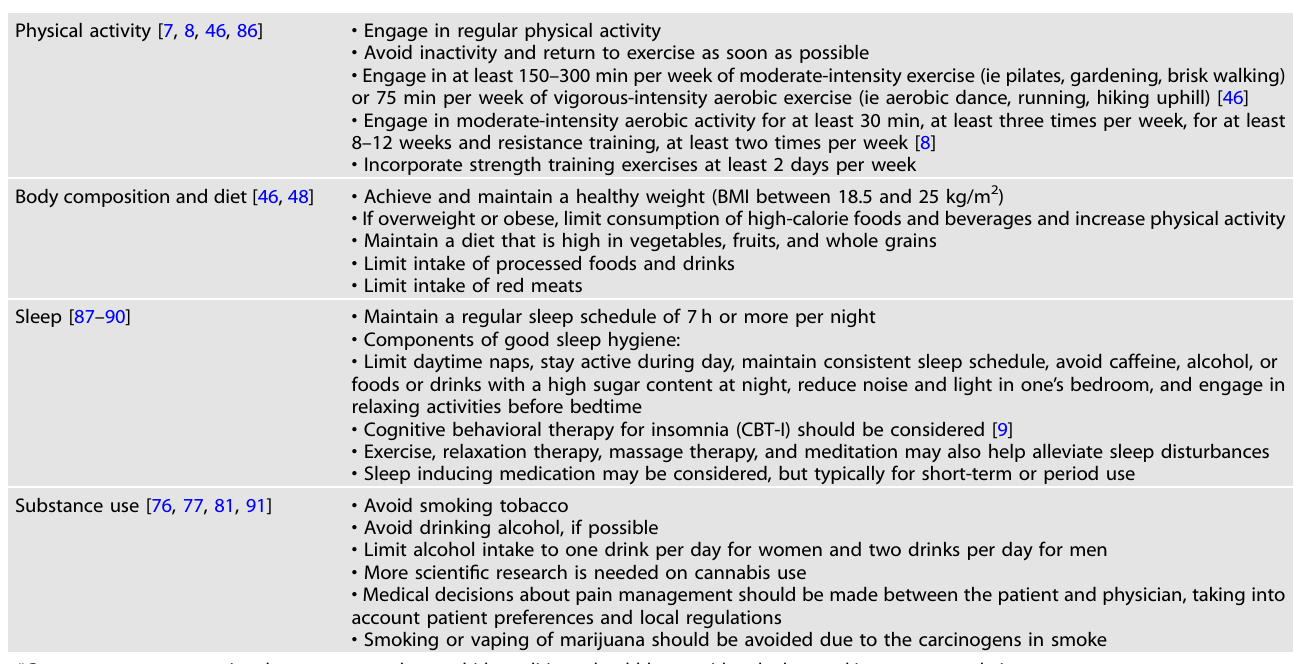
Table 3. Lifestyle guidelines for adult cancer